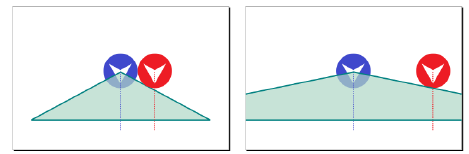
Figure 5. The closer the agents are, the lower will be the angle necessary for them to see each other. Assuming that the agents have the same radius R , the lowest angle necessary so that the two agents can see each other is calculated from the configuration illustrated in Figure 6. In that case, the agents are side by side and the distance between their centers is equal to 2 R . Given that, the vision angle should be 2 α and the value of alpha = 60 ◦ . For this reason, is arccos = Π 3